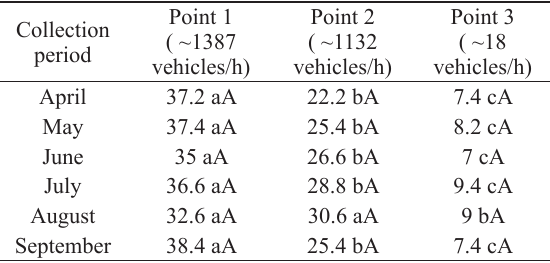
Average numbers of micronuclei observed in tetrads of Tradescantia pallida at the three sampling points in relation to the different collection periods, indicating their statistical differences as